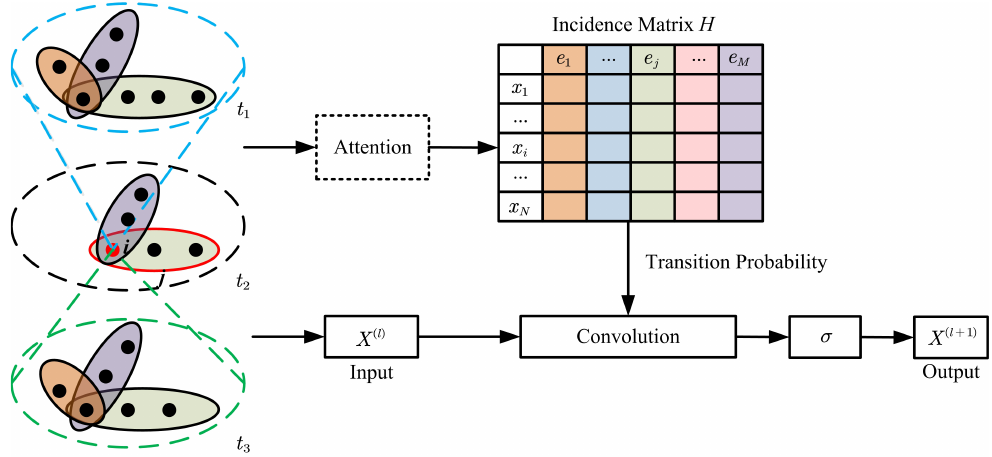
Figure 3. The process of evolving hypergraph attention. (Hypergraph convolution is upgraded to hypergraph attention by attention